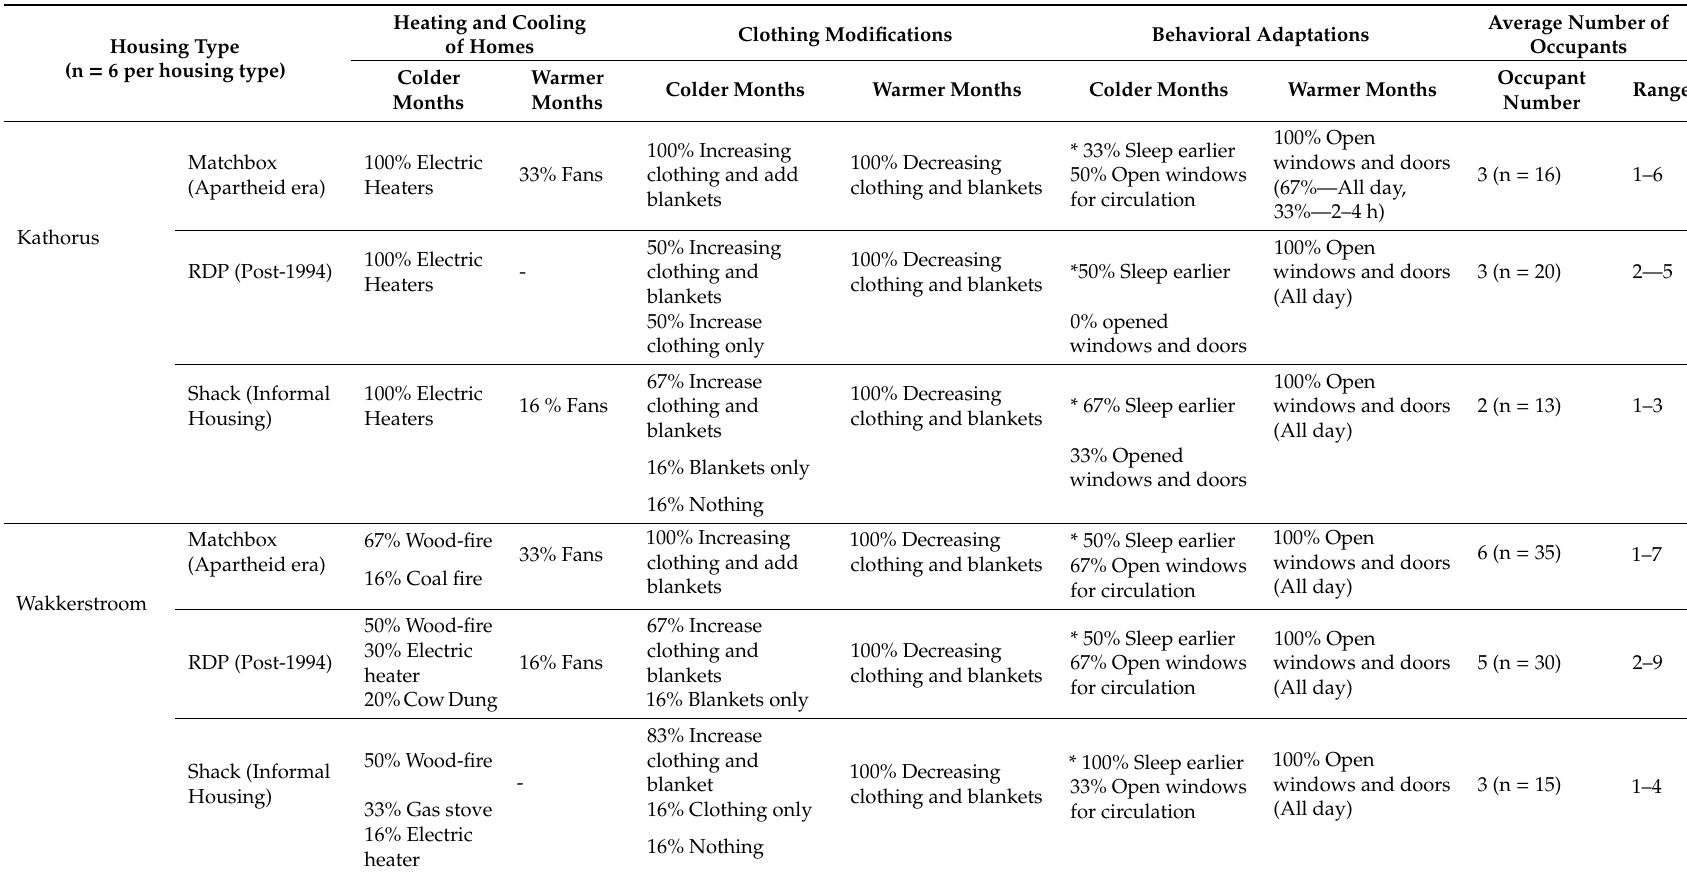
Table 3. Self-reported adaptation methods used in Kathorus and Wakkerstroom during the colder and warmer